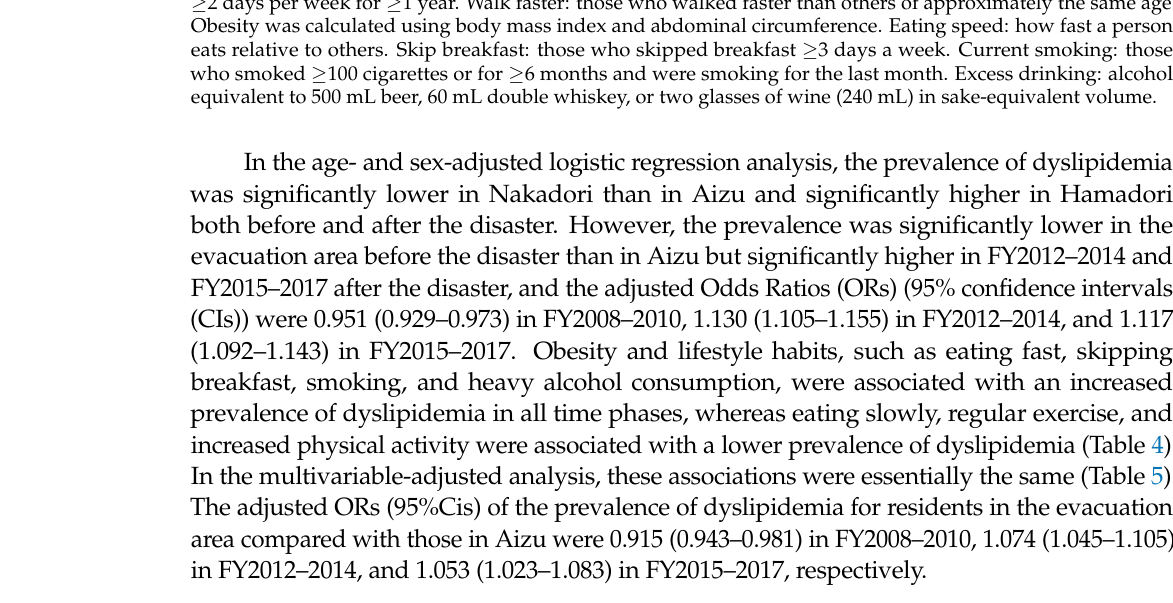
Table 4. Logistic regression analysis to determine the effect of specific factors on